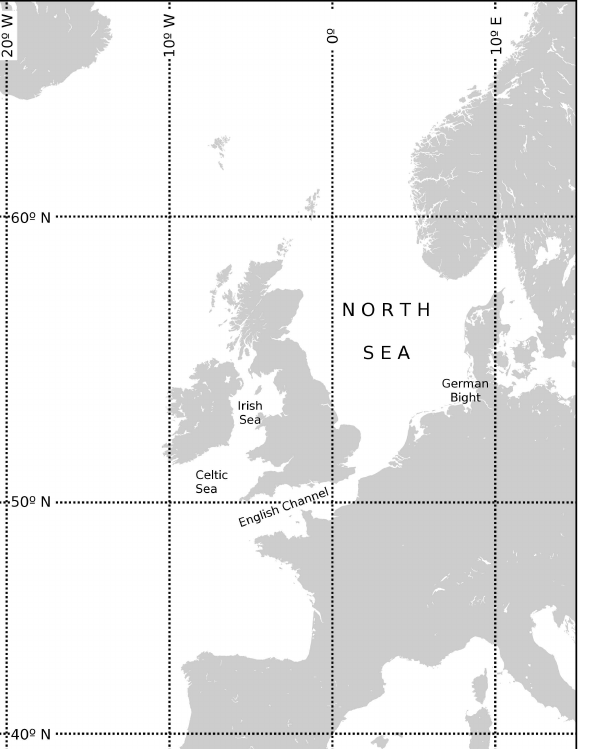
model and the validation of this particular set-up are provided by Artioli et al. (2012) and Holt et al.